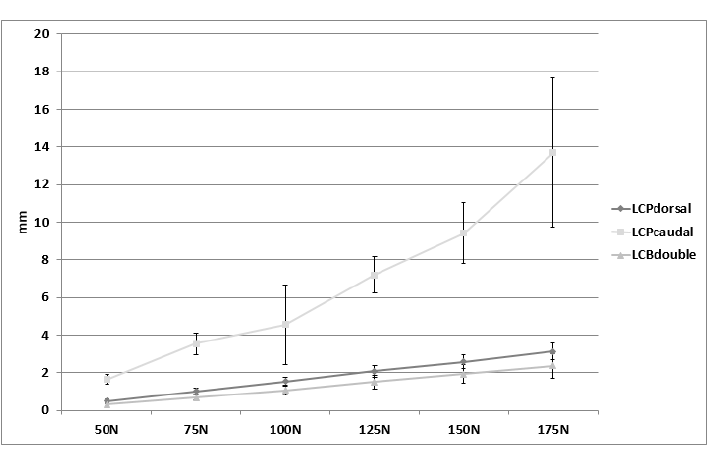
Figure 6. Interfragmentary motion (mean and standard deviation) of the acromion over several load levels (50 to 175 N) of the three constructs.